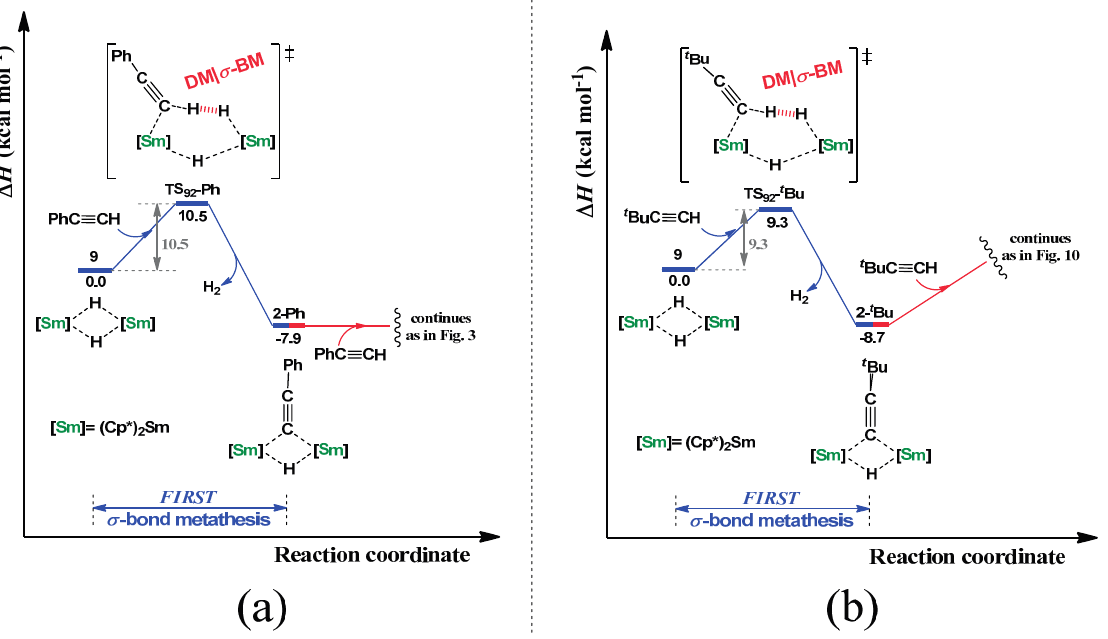
Figure 9. Enthalpy energy Δ H (kcal·mol − 1 ) profiles for the formation of the corresponding trienediyl complexes using ( a ) PhC ≡ CH, and ( b ) t BuC ≡ CH as substrates, and [(Cp * ) 2 Sm( μ -H)] 2 as a precursor. Cp * ligands are omitted for